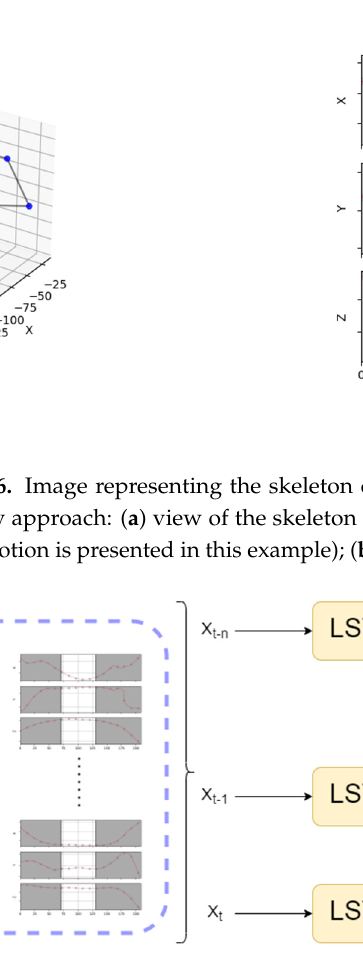
Figure 7. Overview of the complete LSTM NN for activity recognition.